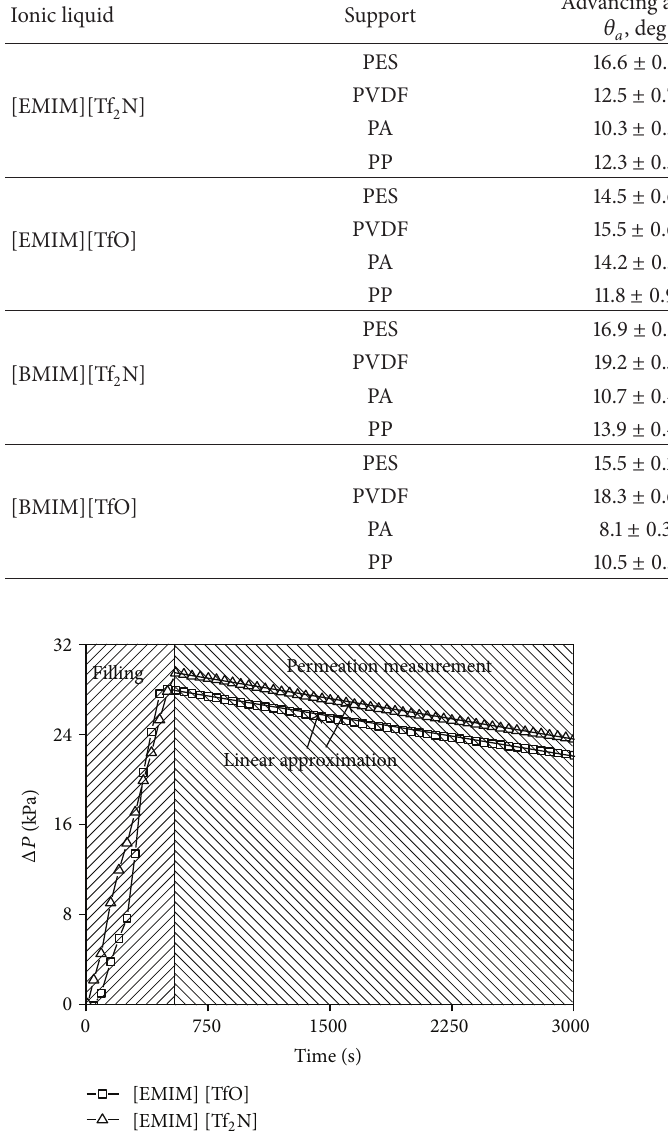
Figure 2: Linear approximation of pressure difference.